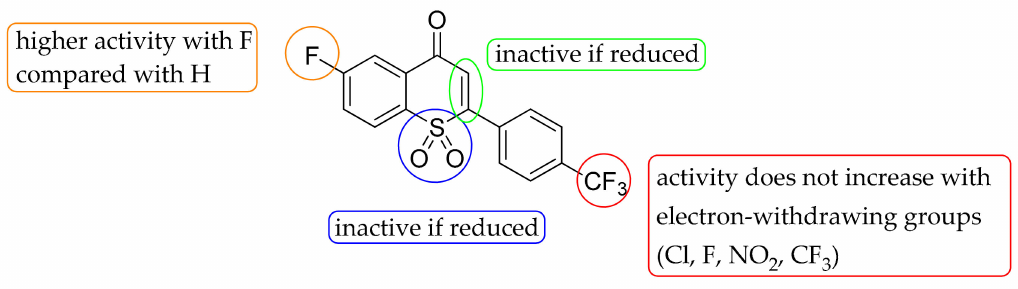
Figure 1. Structure activity relationships of thiochroman-4-one